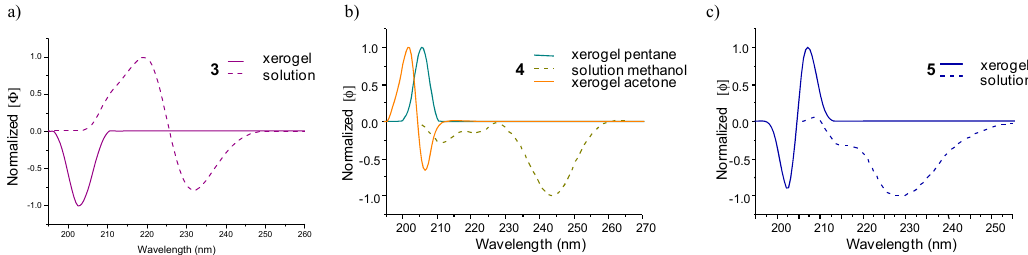
Figure 7. ( a ) Normalized CD spectra of methanol solution (2.47 mM) and xerogel at the mgc from toluene in KBr (20 mM) of 3 at 25 °C; ( b ) Normalized CD spectra of methanol solution (2.56 mM) and xerogels at the mgc in acetone and pentane, respectively, in KBr (20 mM) of 4 at 25 °C; ( c ) Normalized CD spectra of 5 in methanol solution (2.17 mM) and xerogel at the mgc from toluene in KBr (20 mM) at 25 °C.